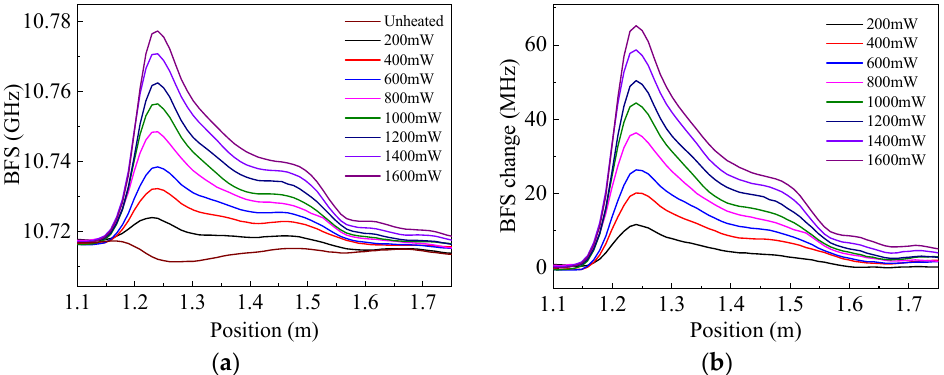
Figure 2. Brillouin frequency shift (BFS) distributions of the sensing optical fiber under different heating powers of the self-heated high-attenuation fiber (HAF): ( a ) Distributions of BFS; ( b ) Distributions of BFS change.